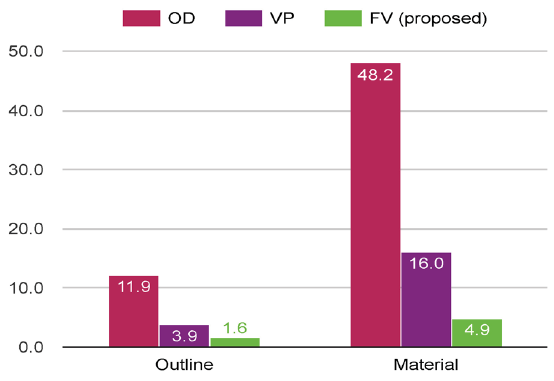
Fig. 5 Geometric mean of time measured in seconds over all 5 test scenes using the visible outline and visible material criteria for each of the three preview methods (smaller time is